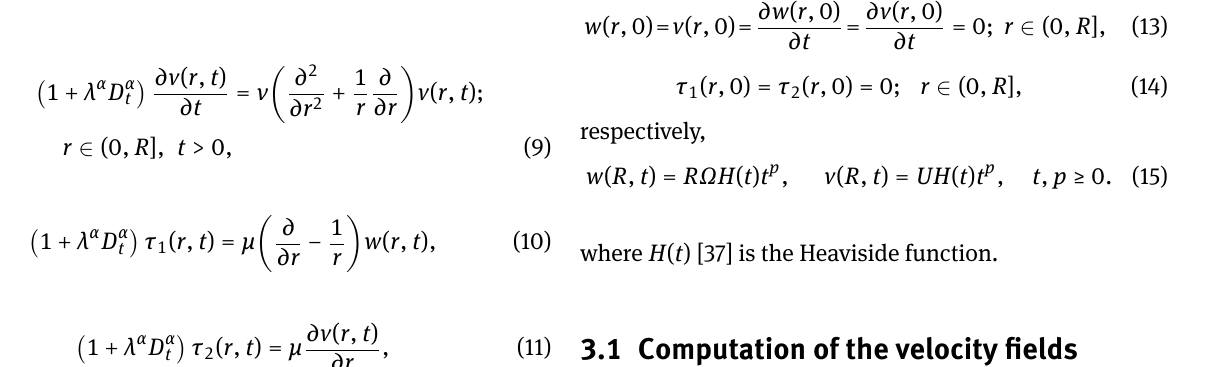
Fig. 1: Geometry of the problem for helical flows of fractionalized Maxwell fluid through a